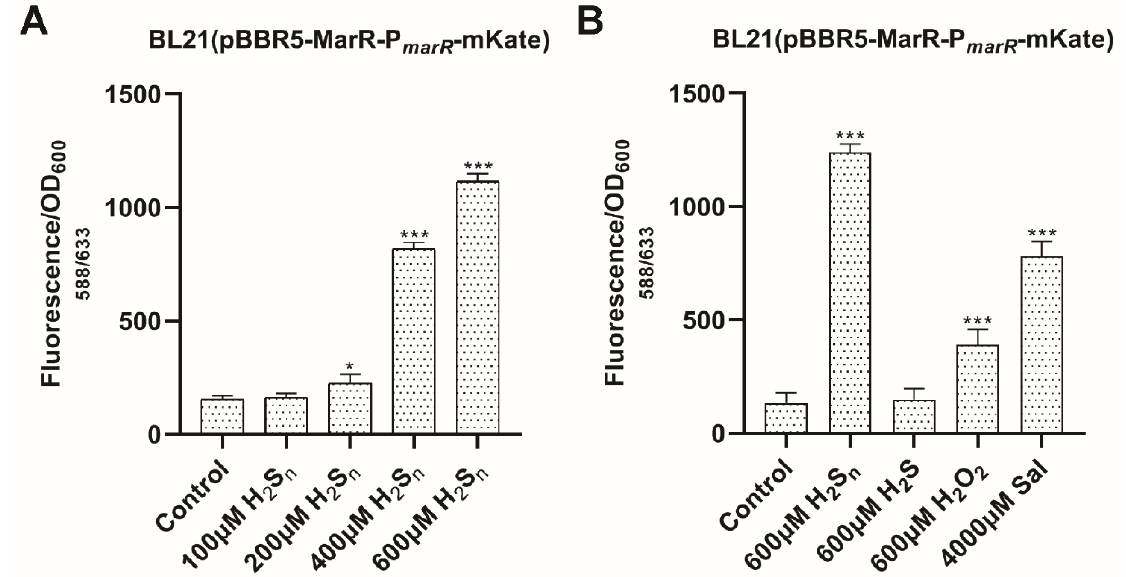
Figure 4. Testing MarR inducers with an E. coli reporter system. ( A ) A dose-dependent induction of mKate. ( B ) mKate induction by several tested inducers. E. coli BL21(DE3) containing pBBR5-MarR-P marR -mKate grew in LB medium to OD 600nm of 0.6, inducers were added, and the cultures were incubated at 37 °C for 2 h before mKate fluorescence analysis. The control was E. coli BL21(DE3) with the empty vector pBBR1MCS5. Student’s t -test was used to calculate the p -value. Symbol * indicates the sample is different (0.05 < p < 0.01) and symbol *** indicates the sample is significantly different from the control ( p < 0.001).